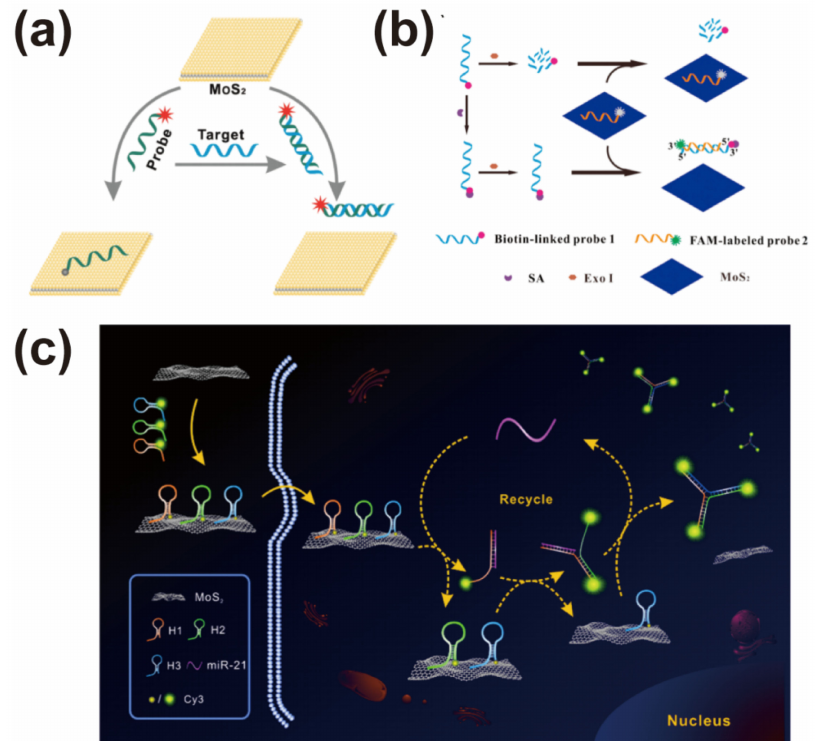
Figure 6. ( a ) Cartoon of MoS 2 -based fluorescence sensor for DNA detection. Reprinted with per- mission from [23]. Copyright 2013, American Chemical Society. ( b ) Illustration of Exo III-assisted fluorescence biosensor for streptavidin detection based on MoS 2 -based nanoprobe. Reprinted with permission from [69]. Copyright 2015, Elsevier. ( c ) MoS 2 -based nanoprobe coupled with signal amplification strategy for ultrasensitive detection and imaging of miRNA-21 expression in living cells. Reprinted with permission from [95]. Copyright 2019, American Chemical